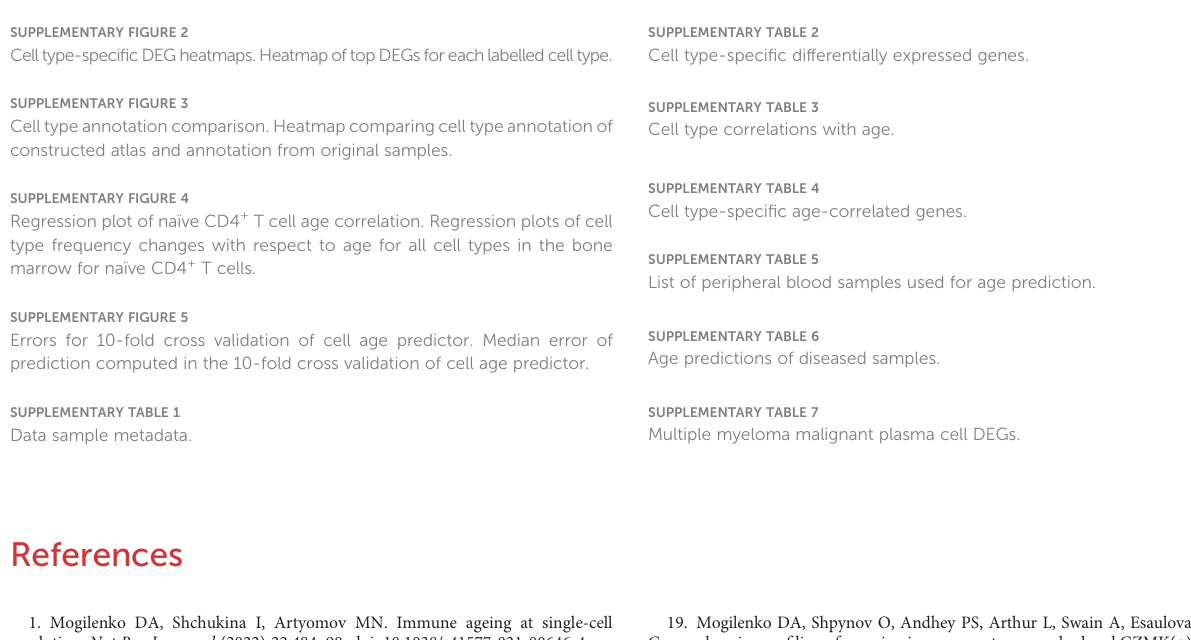
SUPPLEMENTARY TABLE 3 Cell type correlations with age.